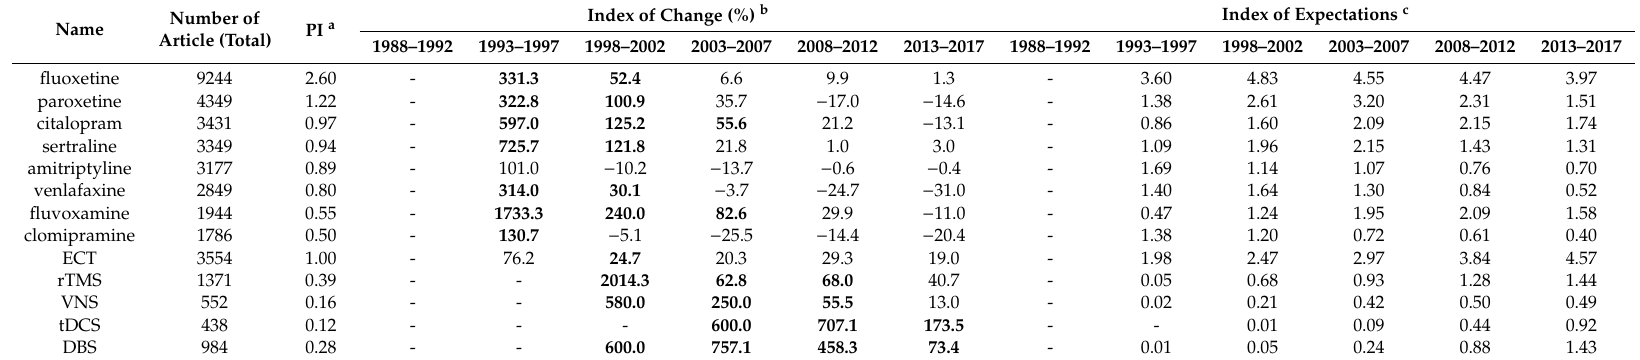
Table 1. Index of change and expectations of biological treatments for the major depressive disorder